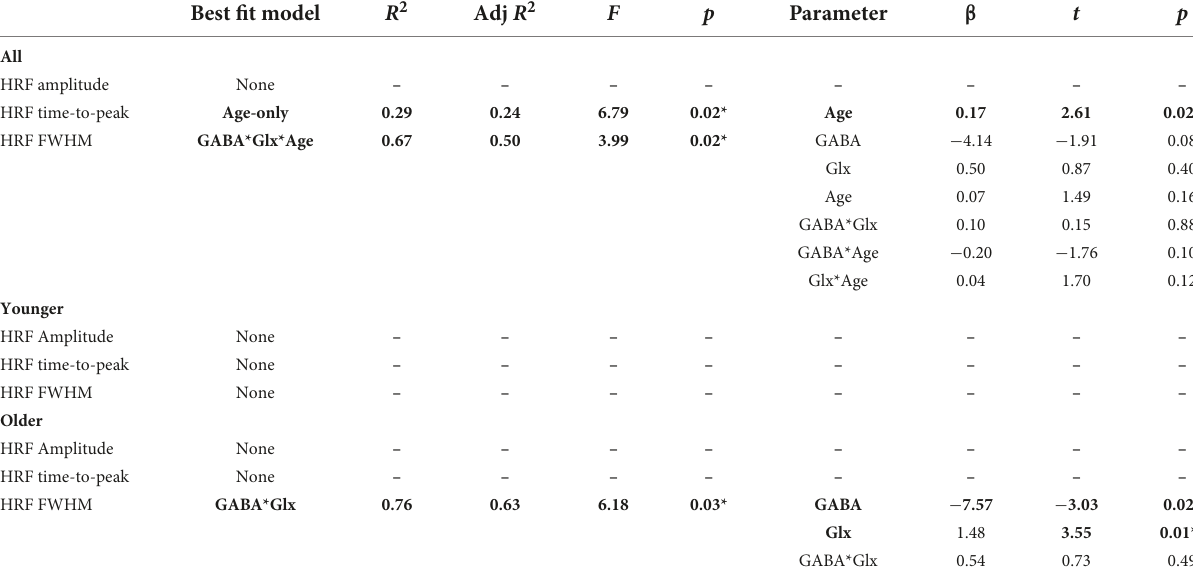
TABLE 2 Best fit neurophysiological model for HRF amplitude, time-to-peak, and FWHM. Best fit